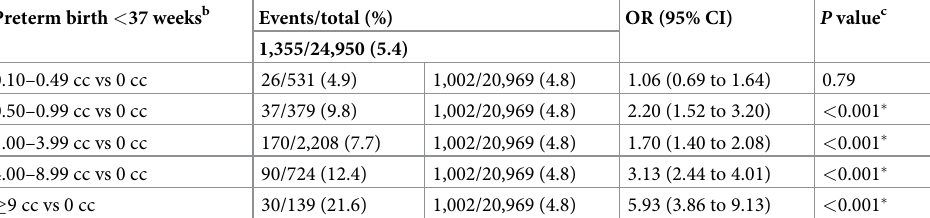
Table 3. Multivariable logistic regression for preterm birth per volume taken from the cervix before each childbirth a . Preterm birth < 37 weeks b Events/total (%) OR (95%